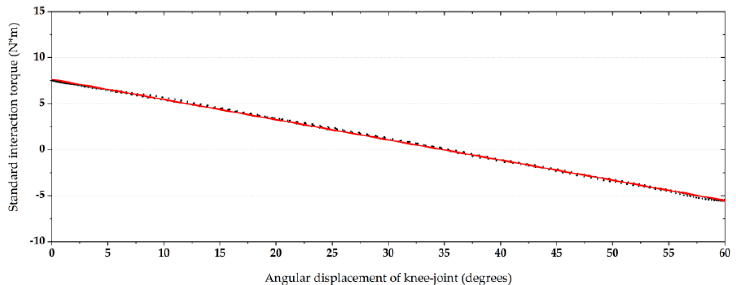
Figure 9. Measured data. ( a ) Motion trajectory of the hip joint (black line) and knee joint (red line). ( b ) Measured interaction torque of the knee joint.